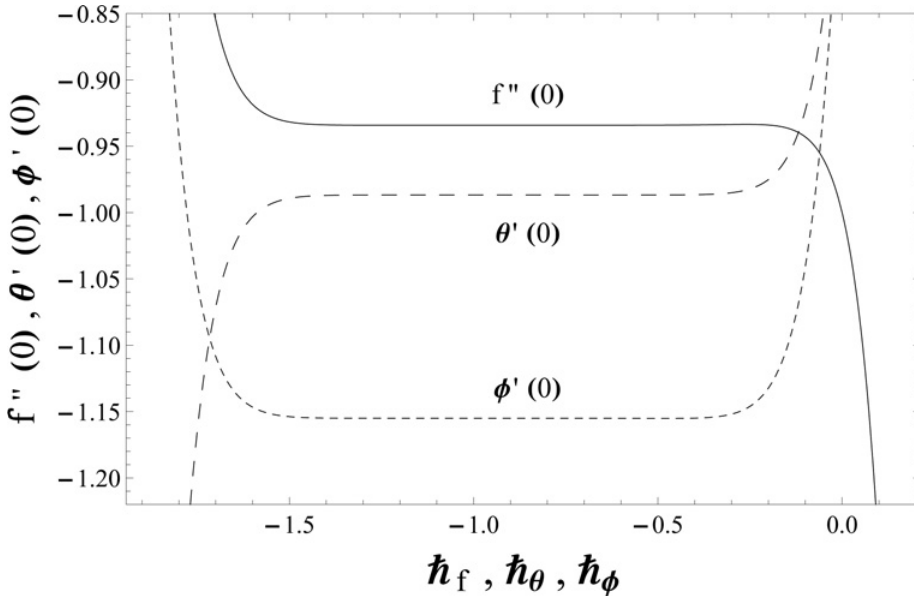
Fig 1. The ℏ (cid:2) curves for the functions f ( η ), θ ( η ) and ϕ ( η ) when β 1 = β 2 = 0.2 = γ = Rd , λ = 0.1 = N , Pr = 1.0 = Sc and ε 1 = 0.3 = ε 2